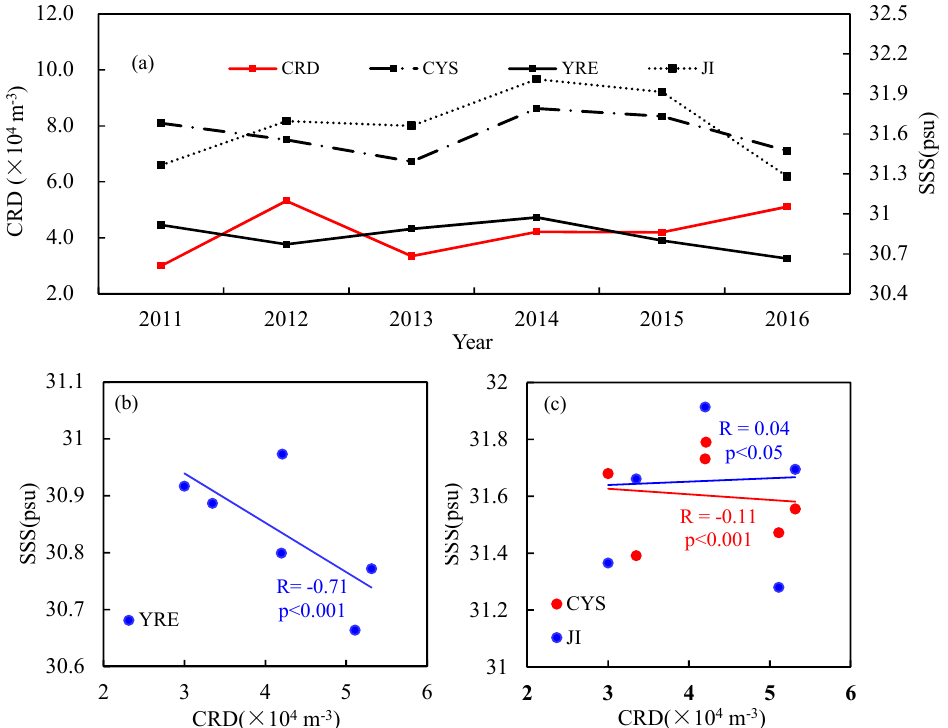
Figure 11. ( a ) Monthly Changjiang River discharge (CRD) and the satellite-derived SSS of three subareas of interest in August during 2011 to 2016. Relationship between CRD and the satellite-derived SSS ( b ) in the YRE and ( c ) in the CYS (red points) and the JI (blue points). The solid lines are the fitted lines.